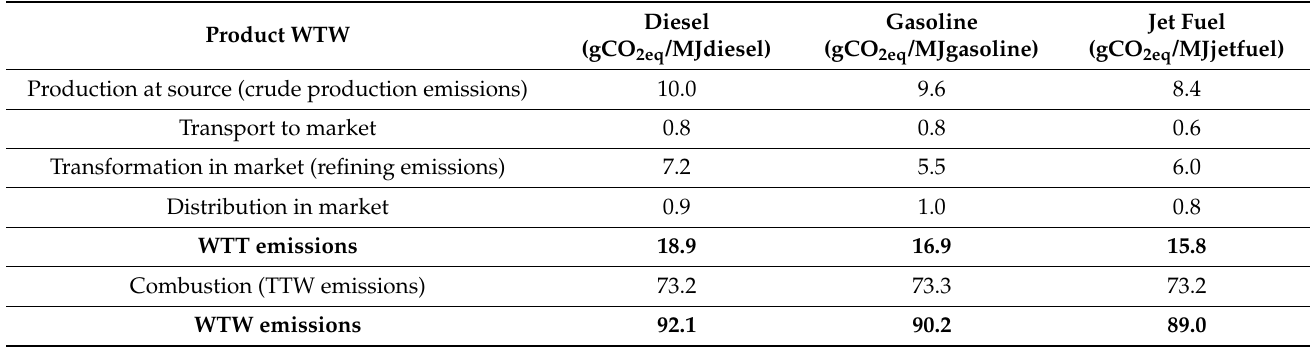
Table 1. WTW GHG emissions for gasoline, diesel and jet fuel.